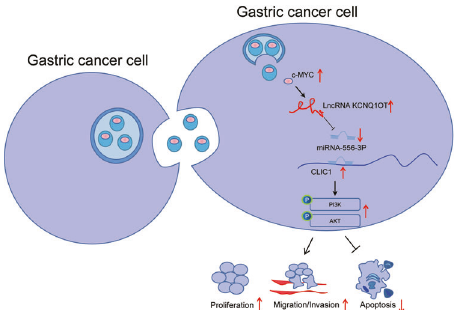
Fig. 8 Molecular mechanism of tumor-derived extracellular vesicles delivering c-Myc affects gastric cancer growth and metastasis via the KCNQ1OT1/miR-556-3p/CLIC1 axis. Tumor- derived extracellular vesicles carrying c-Myc blocked miR-556-3p expression by upregulating KCNQ1OT1 to elevate CLIC1 expression, thus activating the PI3K/AKT pathway and accelerating gastric cancer cell proliferation, invasion, and